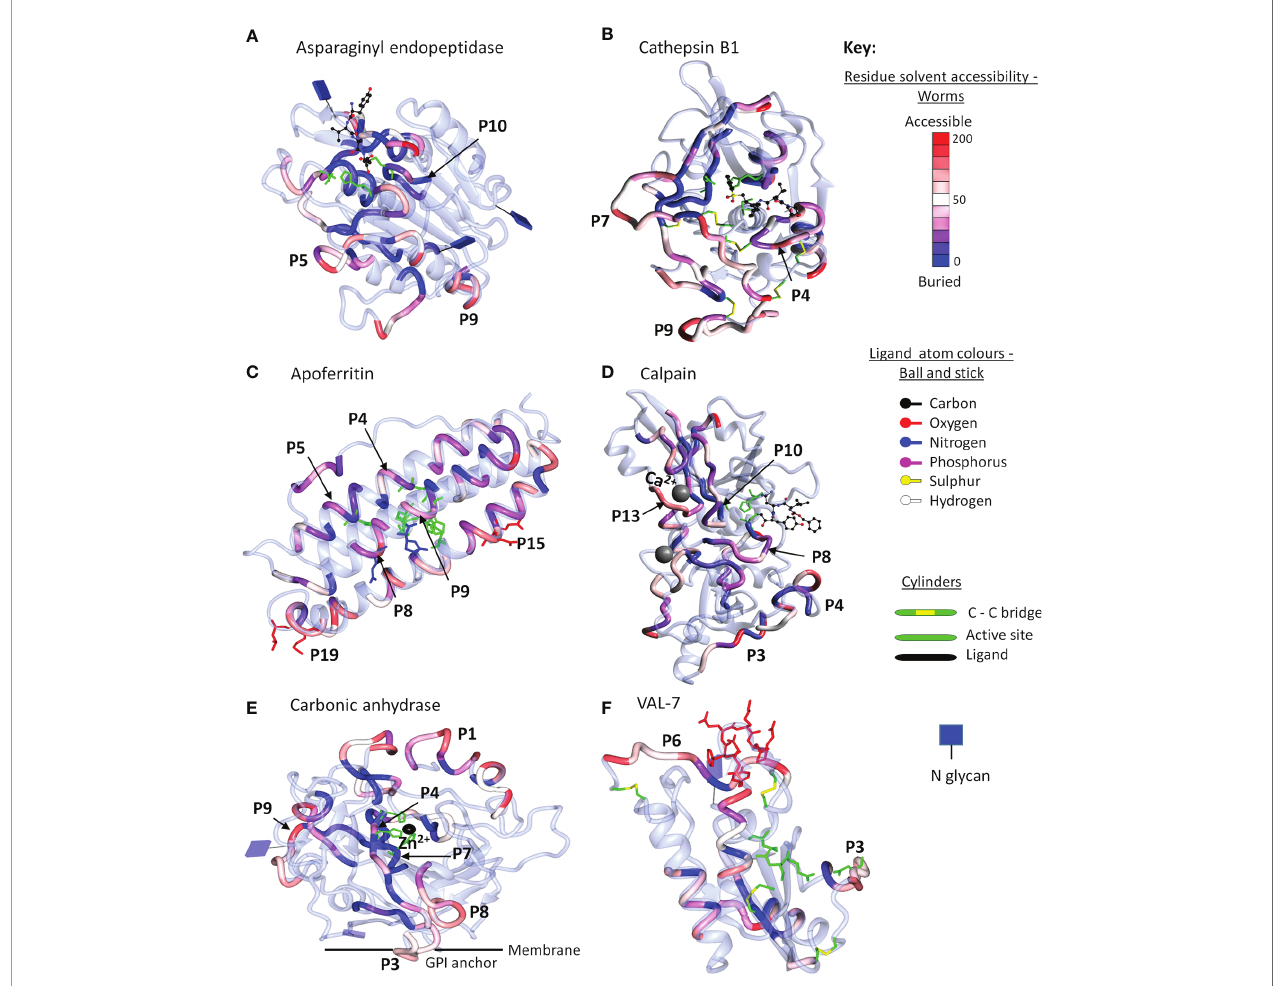
FIGURE 6 | Reactive regions mapped onto six selected crystal structures using CCP4mg (50). (A) Aspariginyl endopeptidase. (B) Cathepsin B1. (C) Apoferritin. (D) Calpain. (E) Carbonic anhydrase. (F) VAL-7. The protein chain is colored ice-blue in ribbon format. The position of each reactive region listed in Supplementary Table 3 is shown in worm format and selected key peptides from Table 1 or Supplementary Table 3 are indicated by P number. The worms are colored by solvent accessibility ranging from buried (blue) to accessible (red) on a scale 0-200 Å 2 , based on the algorithm described by Lee and Richards (51); the detailed key for each model is illustrated in Supplementary Figure 4 . Where present, inhibitors/substrates are displayed in the active site of enzymes in ball and stick format, with atoms colored using a modi fi ed Corey/Pauling/Koltan (CPK) convention, to indicate their location, while the side chains of amino acids comprising the active site or other named features are highlighted as